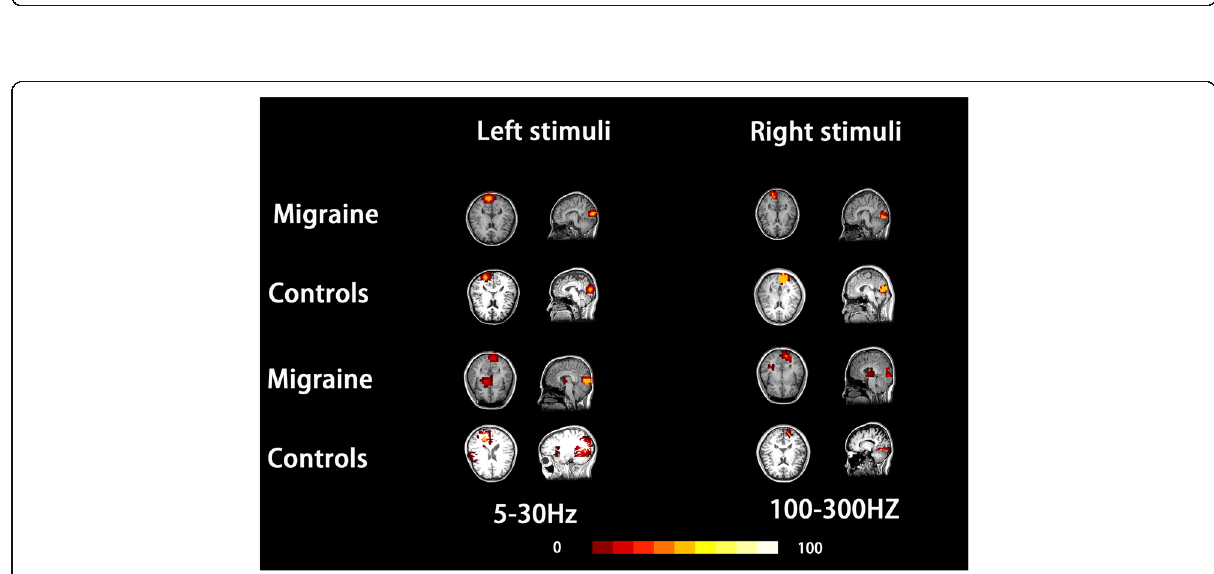
Fig. 4 Source location of V2: Magnetic source imaging (MSI) shows the source of activation of neuromagnetic response evoked by a visual stimulus in 5 – 30 and 100 – 300 Hz frequency bands in a migraine subject (migraine) and a control (control). The neuromagnetic activation evoked by a visual stimulus is mainly localized in the contralateral primary visual cortex (cPVC) in all migraineurs and controls, activation in regions beyond contralateral primary visual cortex (RBcPVC) was also noticed in some of the migraineurs and controls. Those areas included extensive visual cortex and parietal/temporal